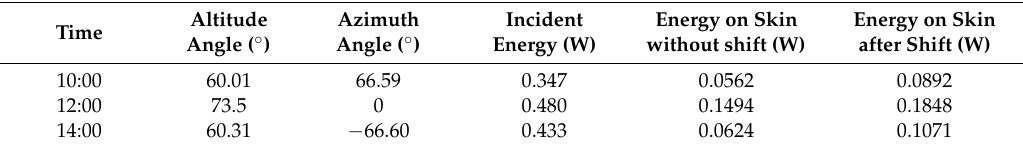
Table 2. The parameters and energies of solar radiation.